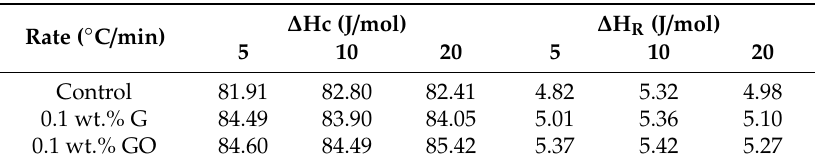
Table 1. Polymerisation enthalpies obtained using the non-isothermal tests for each bone cement type when tested at a di ff erent heating rate. The ∆ H c represents the heat released during the non-isothermal polymerisation of the cement and the ∆ H R is the heat associated with the residual monomer. G = graphene; GO = graphene